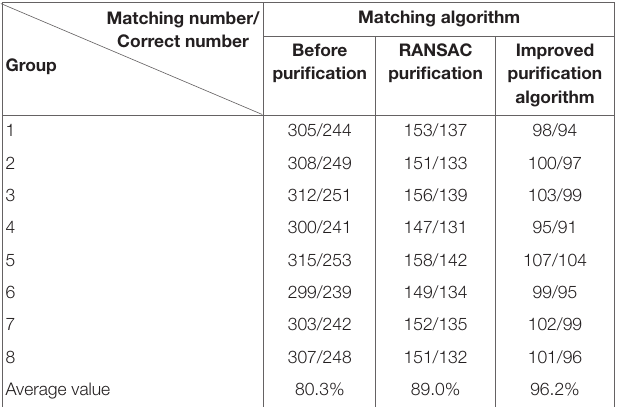
TABLE 2 | Comparison of purification algorithms for feature point matching.